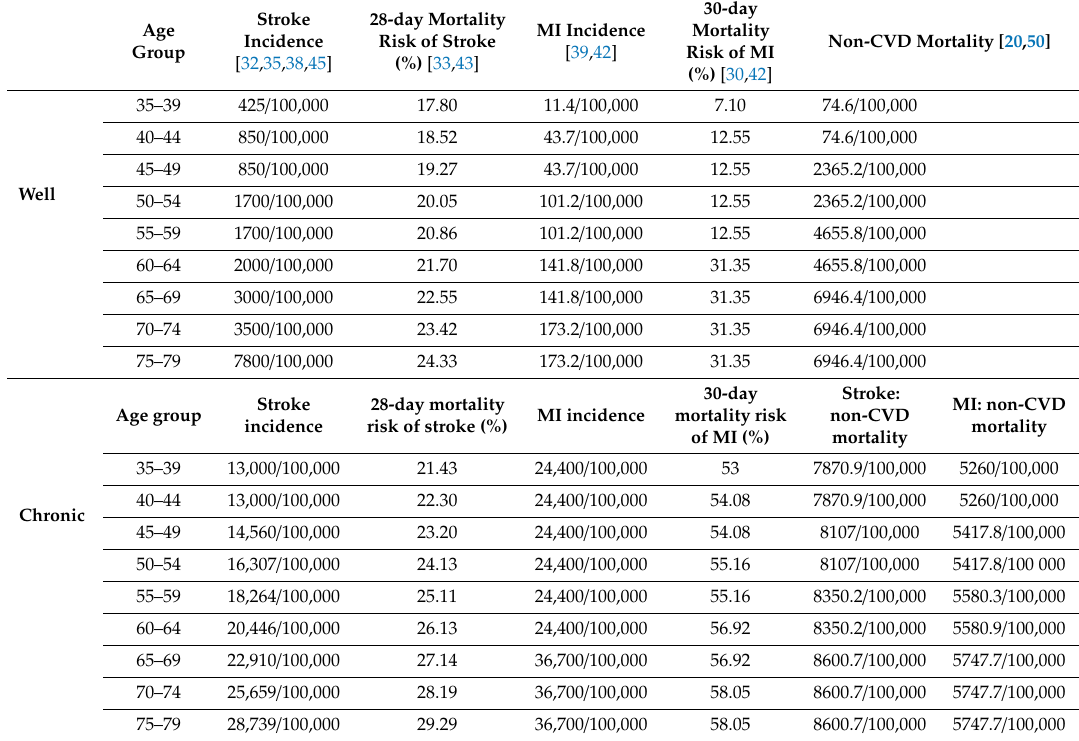
Table 1. Stroke and MI incidence per annum, mortality